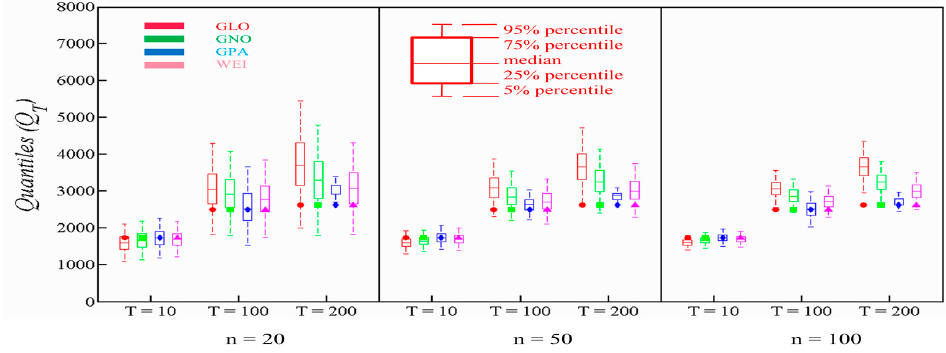
Figure 4. Boxplot for GLO, GNO, GPA and WEI for Panjkora river.